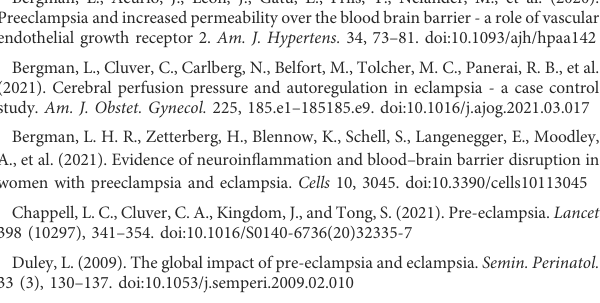
FIGO best practice advice. Int. J. Gynaecol. obstetrics 160 (1), 22 – 34. doi:10.1002/ijgo.